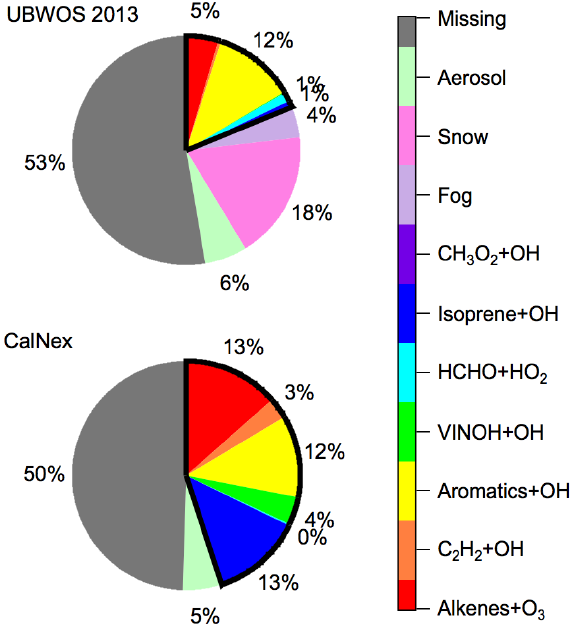
Figure 9. Contributions from various formation pathways to sec- ondary production of formic acid in UBWOS 2013 (upper) and Cal- Nex (bottom). Wedges with black outlines indicate the contributions from gas phase